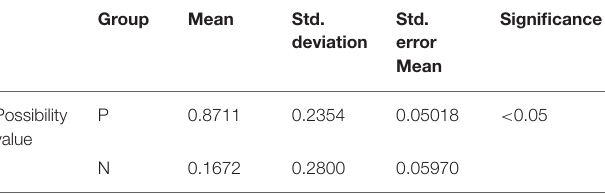
TABLE 2 | Results of possibility values between Positive Group and Negative